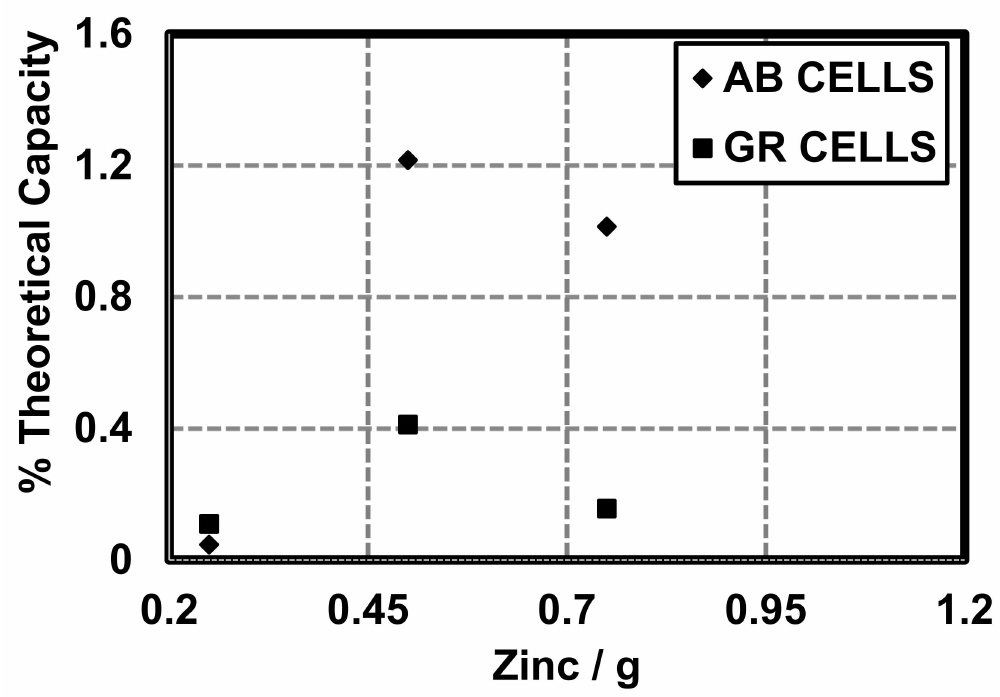
Figure 10. Coulombic e ffi ciency as a % of theoretical coulombic